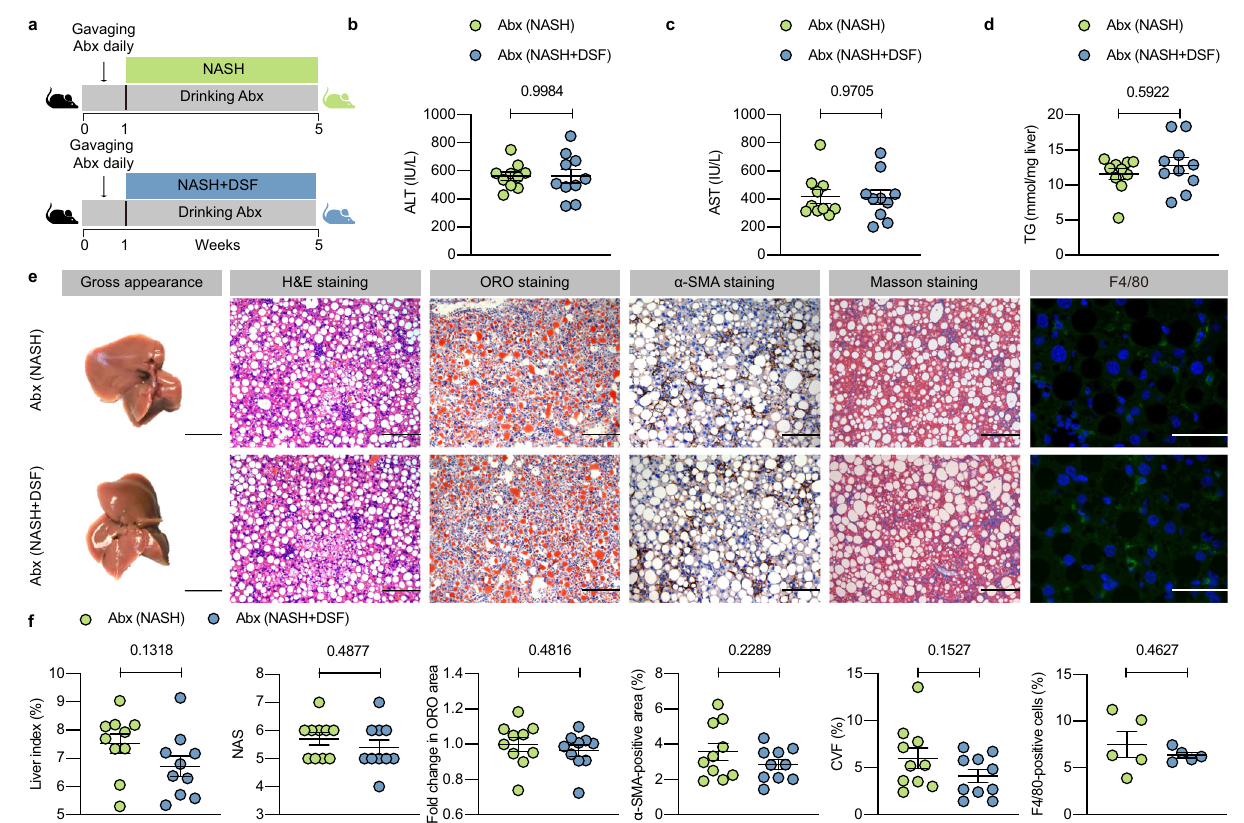
Fig. 1 | Bacterial depletion ablates the ameliorating effects of DSF on NASH. a Abx experimental design. WT mice were put on a course of intragastrically Abx administration for 1 week and received an Abx in the drinking water for another 4 weeks. During the 4 weeks, mice were fed a CDAHFD or CDAHFD+DSF. b – d SerumALTand AST;hepaticTG. e Representativeimagesofgrossappearance of the liver histology (1cm) and photomicrographs of fi xed liver sections after staining with H&E (200 μ m), ORO (200 μ m), α -SMA antibody (200 μ m), Masson (200 μ m) and F4/80 antibody (50 μ m). f Quanti fi cation of the liver index (%), NAS, fold changein ORO area, α -SMA-positive area (%), CVF(%) and F4/80-positivecells